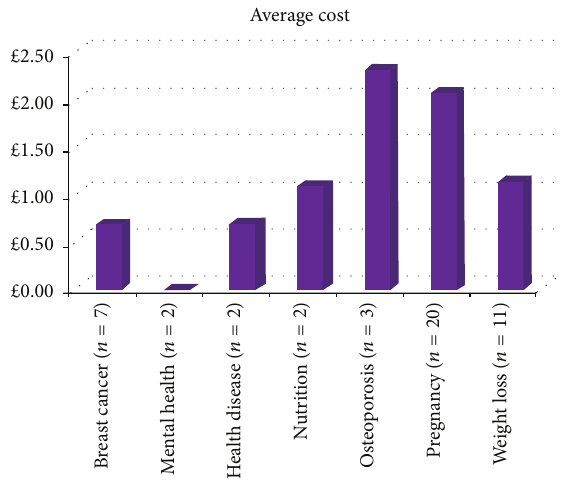
Figure 2: Average cost of women’s health apps from the iPhone store. Note: mental health apps were both free.